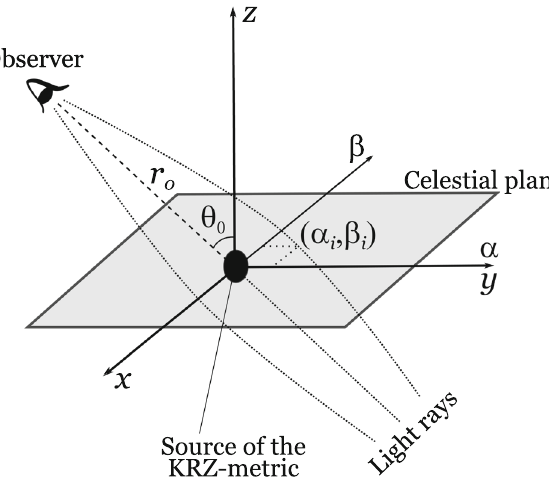
Fig. 4 Schematic illustration of the celestial coordinates used for the ray tracing code in the KRZ spacetime